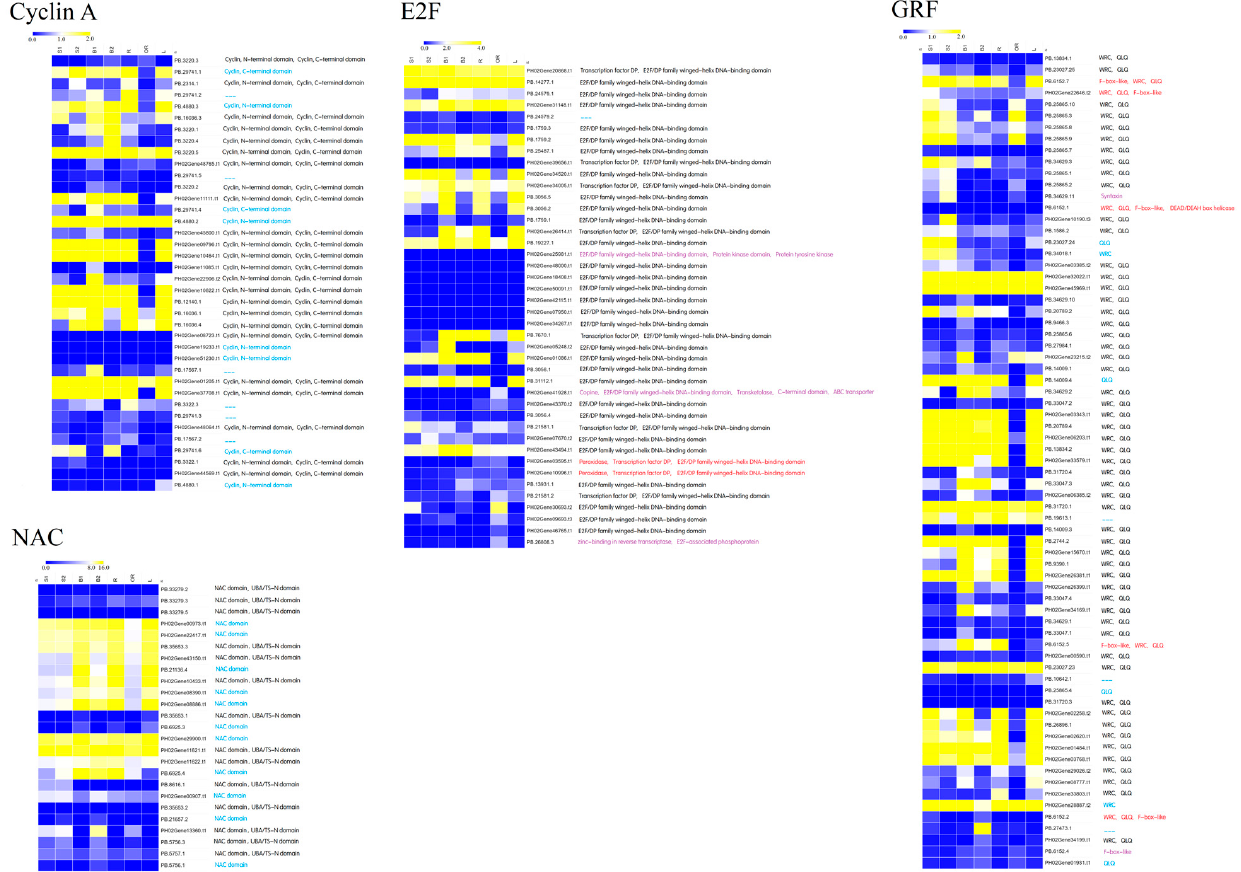
Figure 9. Expression and conserved domain analysis of isoforms from four important plant growth and development families. The color scale represented log2-transformed FPKM values. Yellow indicated high expression and blue indicated low expression. For each isoform, the identified conserved domains were shown following the isoform names. Blue or red represented the isoform that suffered from domain loss or domain acquisition, respectively. Purple represents the domain loss and domain acquisition that simultaneously occurred in that isoform.